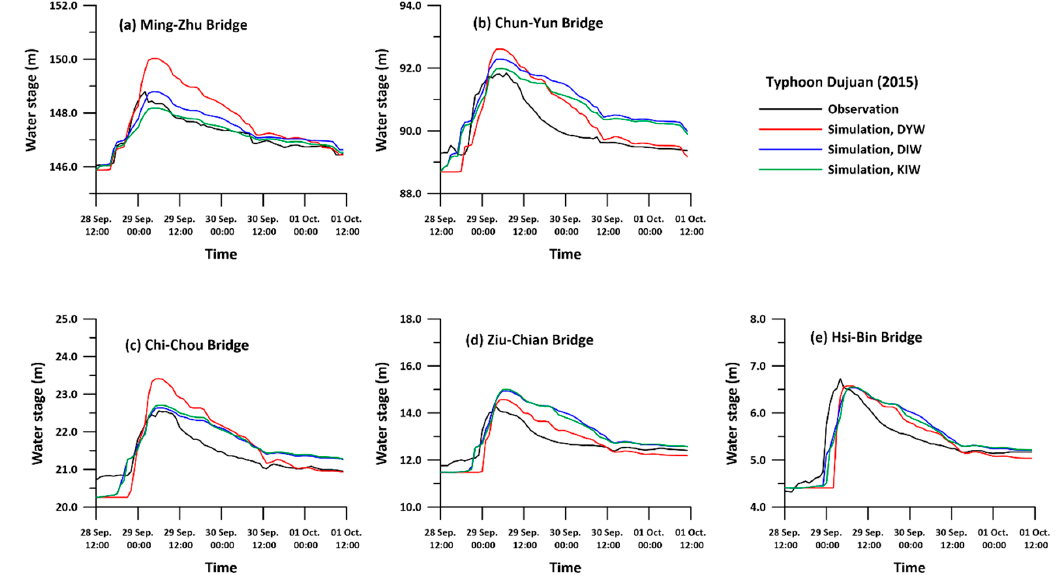
Figure 9. DYW/DIW/KIW simulations of Typhoon Dujuan (2015).